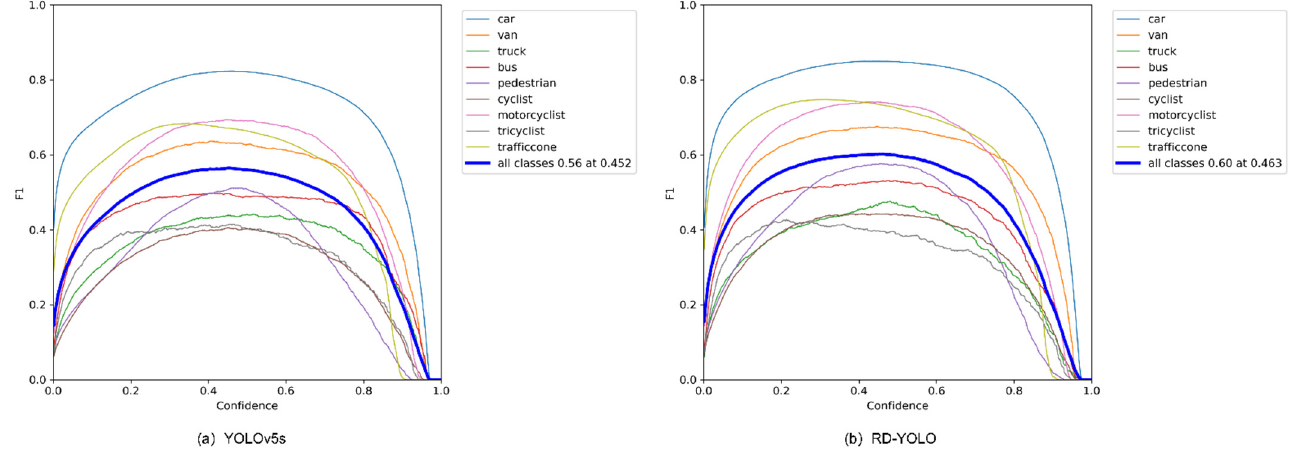
Figure 12. PR-Cure comparison of YOLOv5s and RD-YOLO.